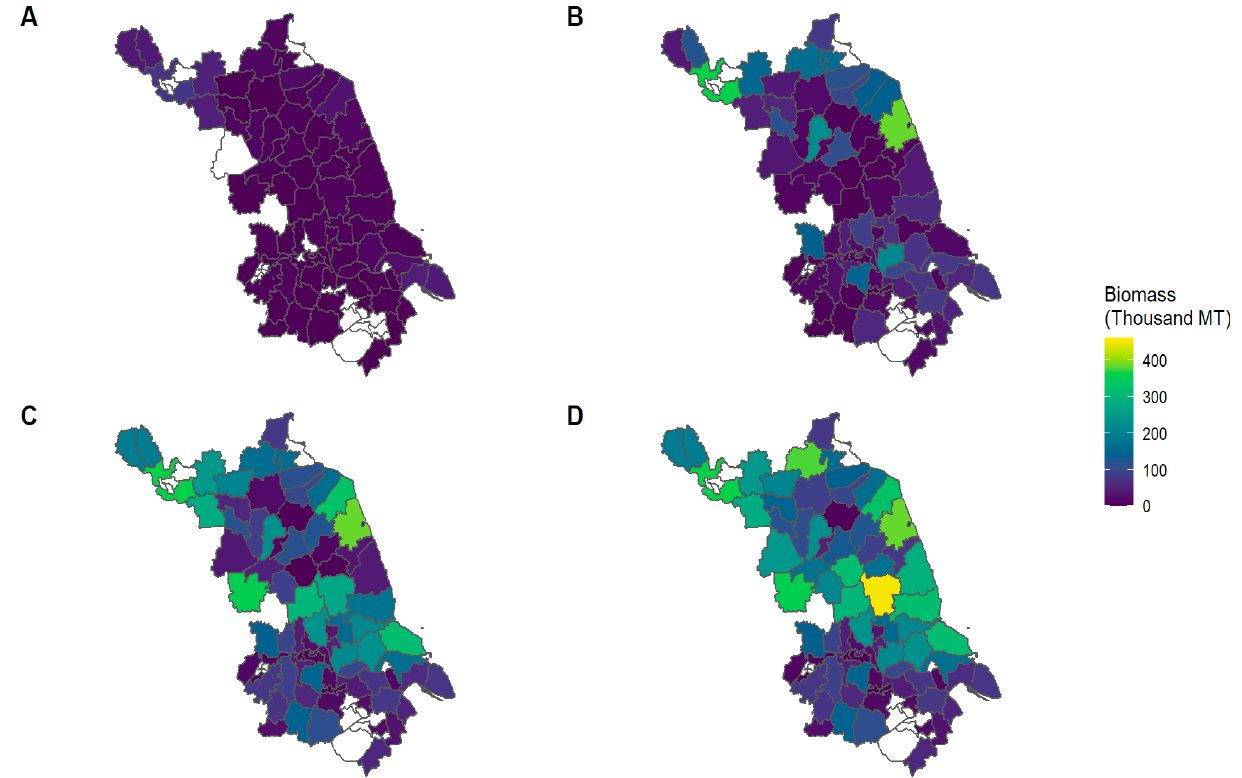
Figure 4. Spatial distribution of feedstock production for alternative levels of biomass price with a 10% co-firing rate: ( A ) USD 50/MT; ( B ) USD 60/MT; ( C ) USD 70/MT; ( D ) USD 80/MT.